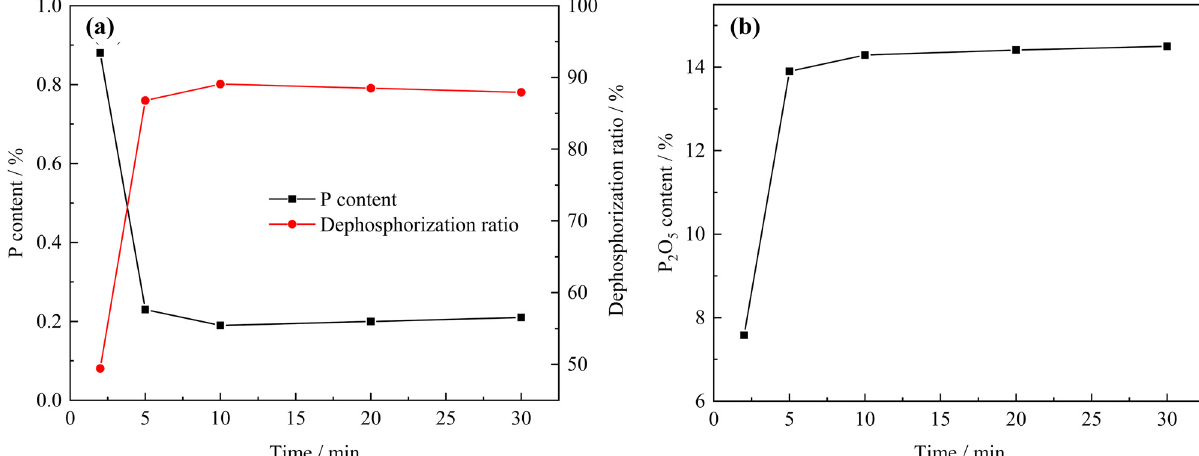
Figure 1: E ff ect of the dephosphorization time on the P content of the fi nal metal and the P 2 O 5 content of the high - P - containing slag: ( a ) P content and dephosphorization ratio and ( b ) P 2 O 5